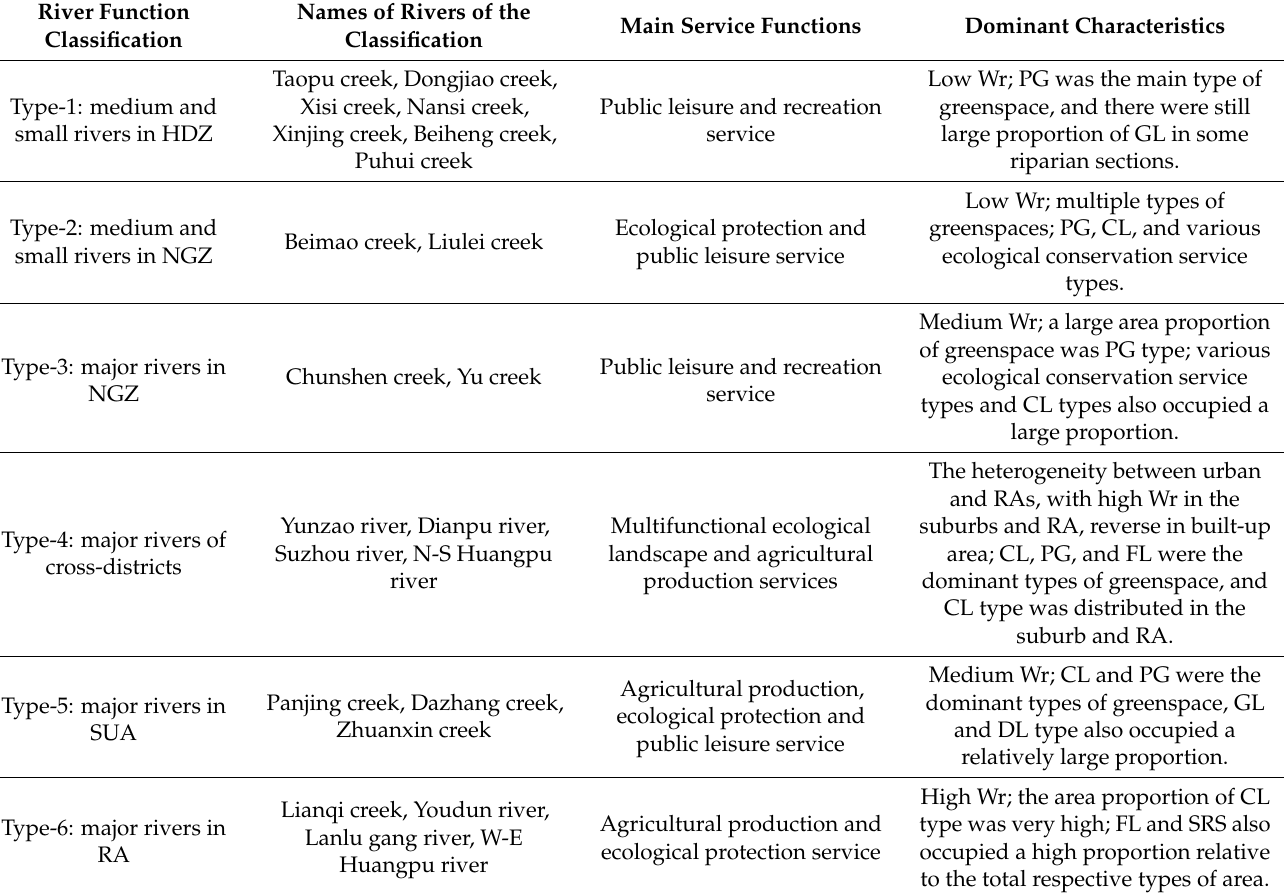
Table 7. The composition characteristics of riverfront greenspaces in different river-type